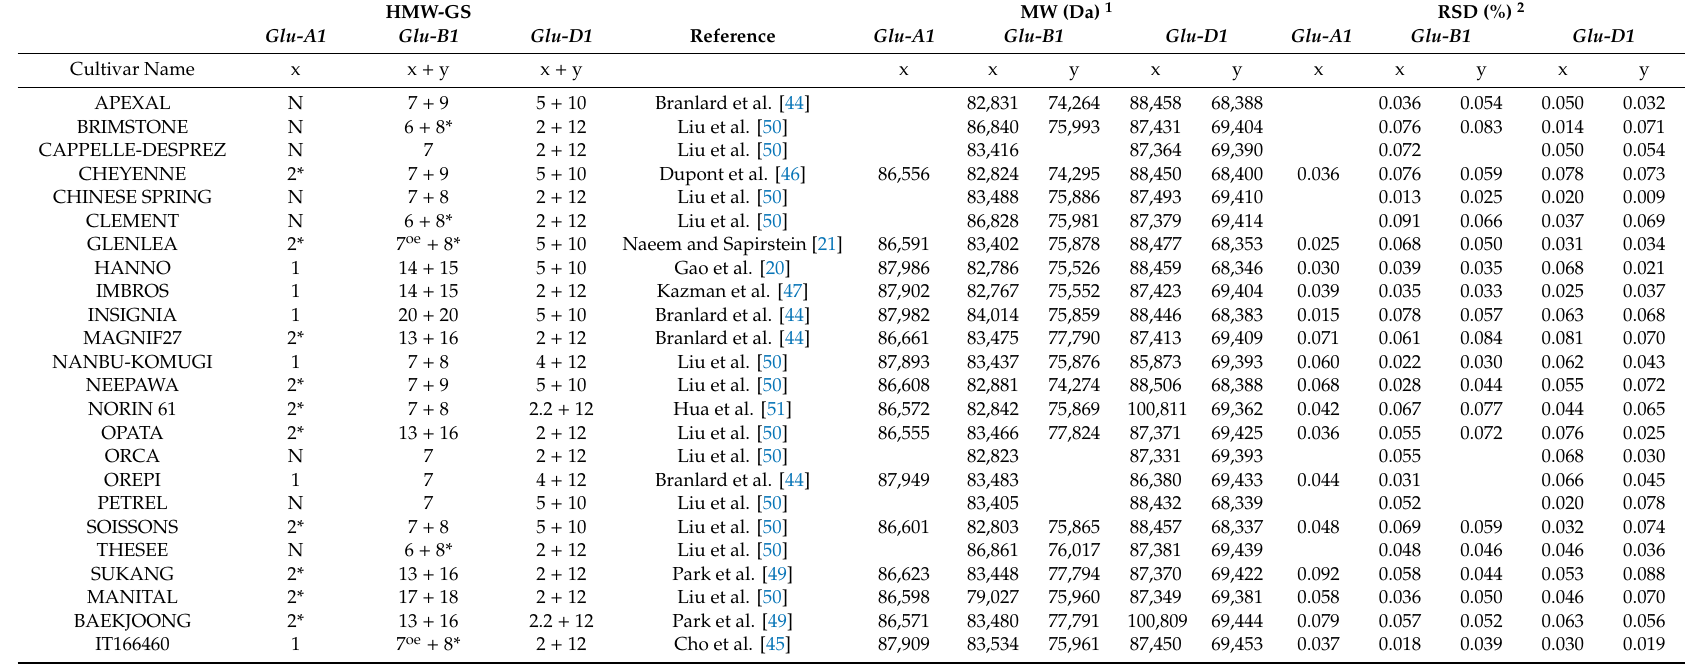
Table 2. Reproducibility of molecular weights for HMW-GS determined by MALDI-TOF-MS in standard wheat